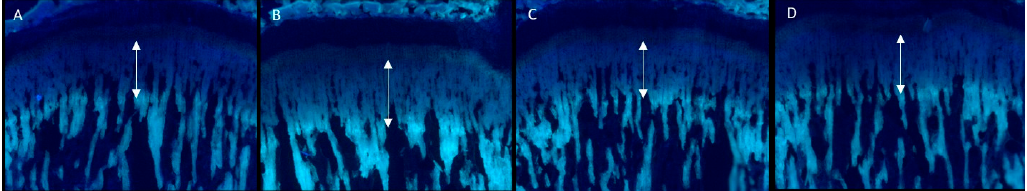
Figure 2. Representing fluorescent microscopic pictures of the proximal tibial growth plate (GP). The double arrows indicate the distances between the chondrocyte-bone junction and the proximal endline of the tetracycline label which represent bone growth during 72 h. ( A ) control group, ( B ) rhGH 200 μ g/kg group, ( C ) EEM 50 mg/kg group, and ( D ) EEM 200 mg/kg group. Scale bar is 200 µ m.